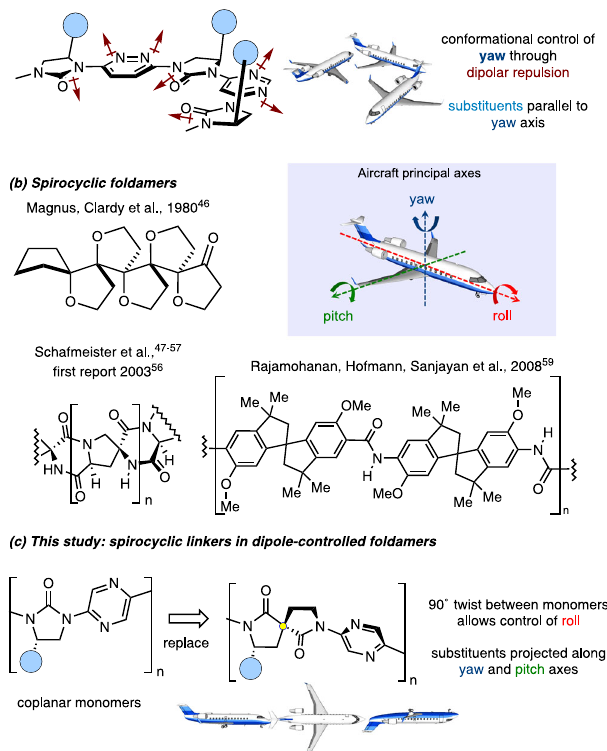
Fig. 1 Overview of this study and its precedent. a Dipole-controlled foldamer allowing control of backbone shape by changing yaw angle. Localised dipoles are indicated (maroon arrows). b Previous foldamers incorporating spircocyles. c The merging of a spirocyclic monomer with the dipole-controlled foldamer concept can allow greater exploration of conformational space, and side-chain vectors along multiple